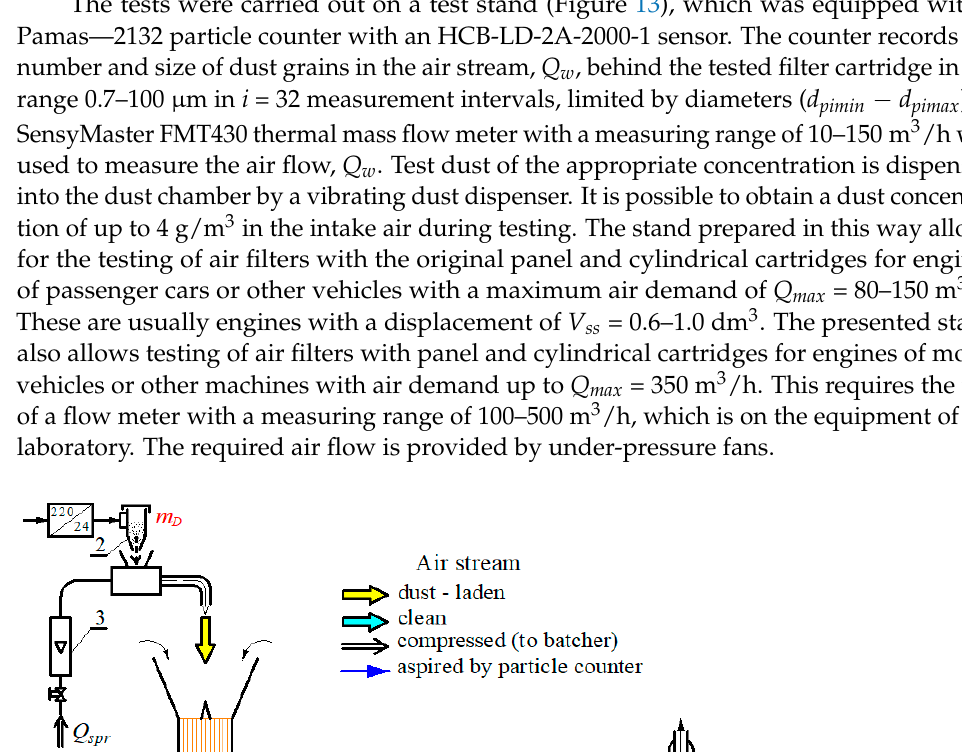
Figure 12. Test filters prepared for testing: ( a ) PowerCore filter—PC, ( b ) PowerCore G2 filter—G2, ( c ) filter with cellulose bed—C, ( d ) filter with polyester bed—P (photos taken by the author).